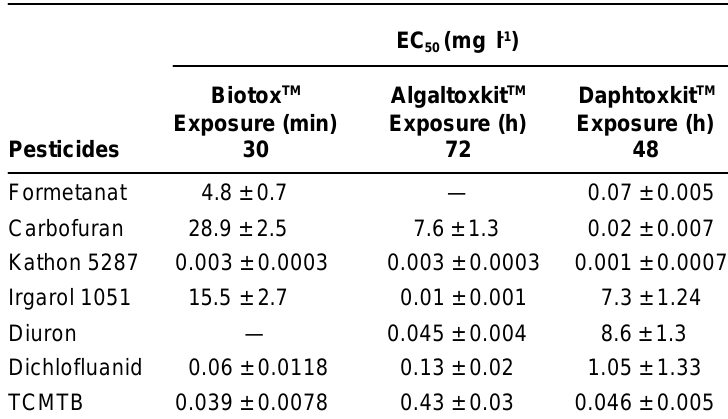
EC Values for Single Pesticides 50